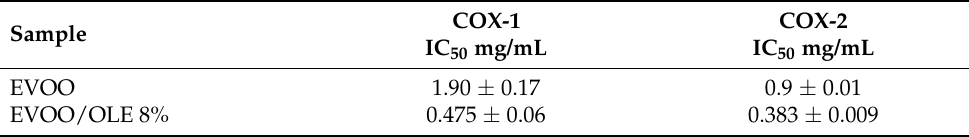
Table 3. Inhibitory effects of EVOO and EVOO/OLE 8% on COX-1 and COX-2.